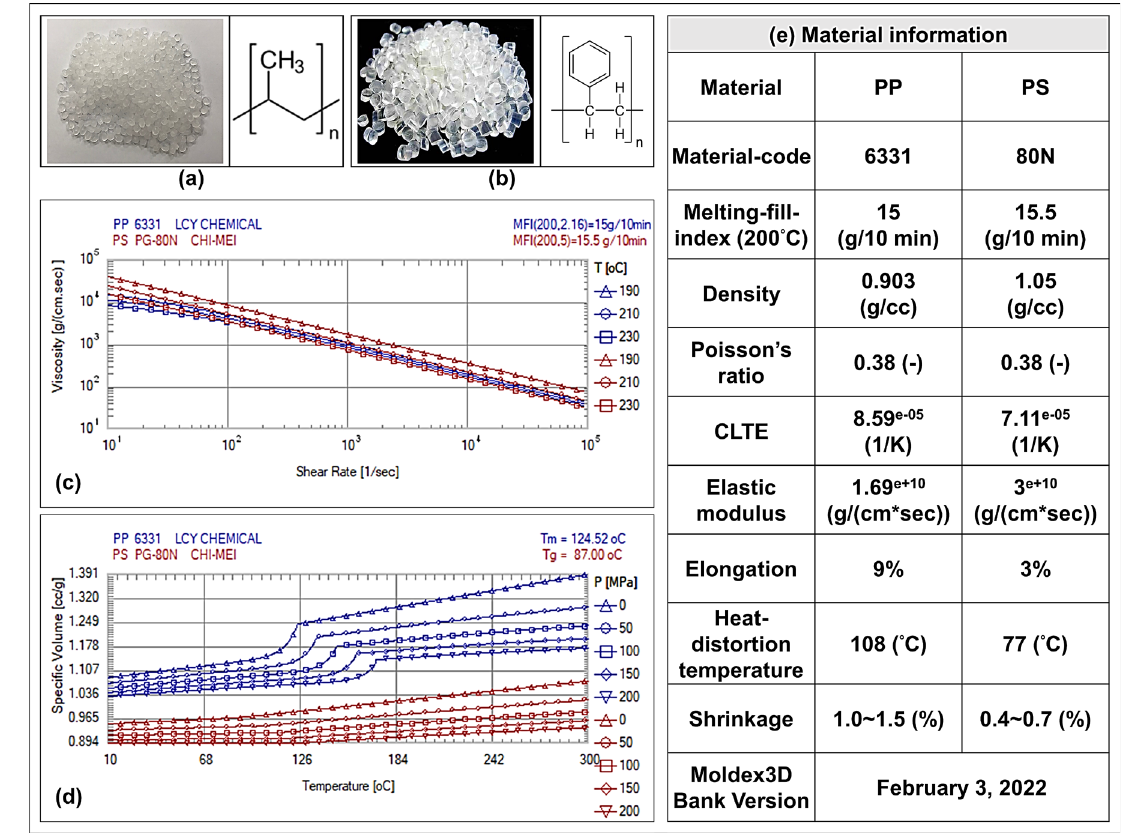
Figure 4. Schematic of experiment materials: ( a ) polypropylene (PP); ( b ) polystyrene (PS); ( c ) viscosity; ( d ) P-V-T relation; and ( e ) material information. (Source ( c – e ): Moldex3D Information Library).